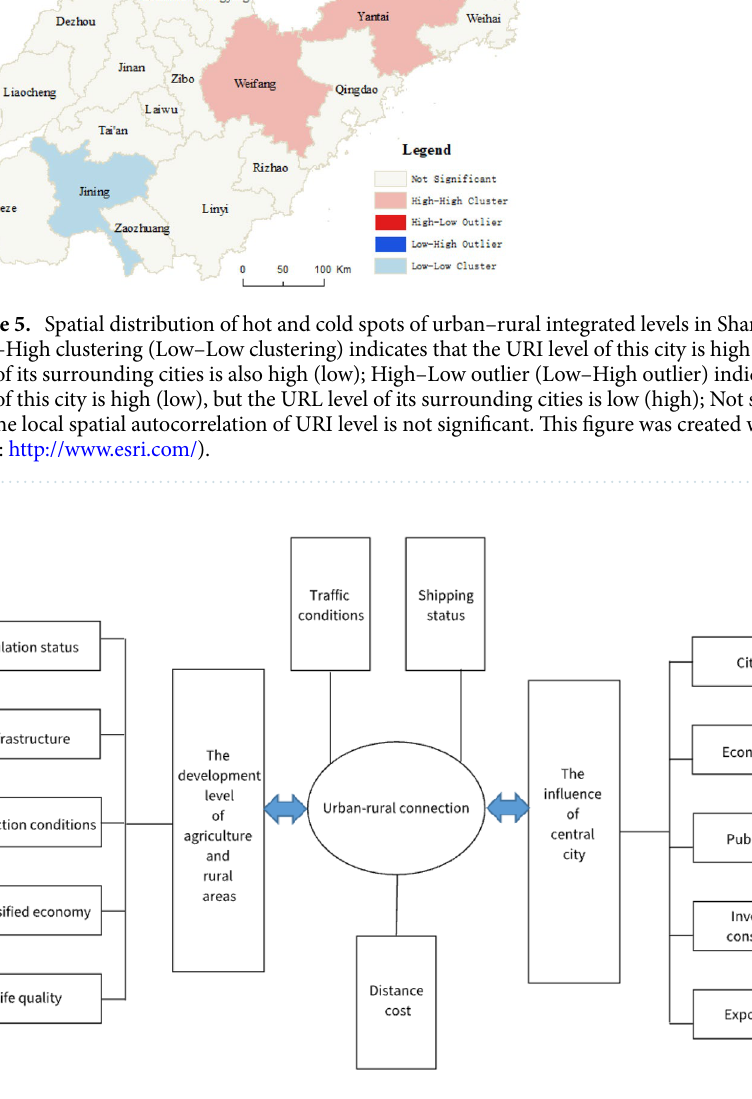
Figure 6. Influencing factors of urban–rural